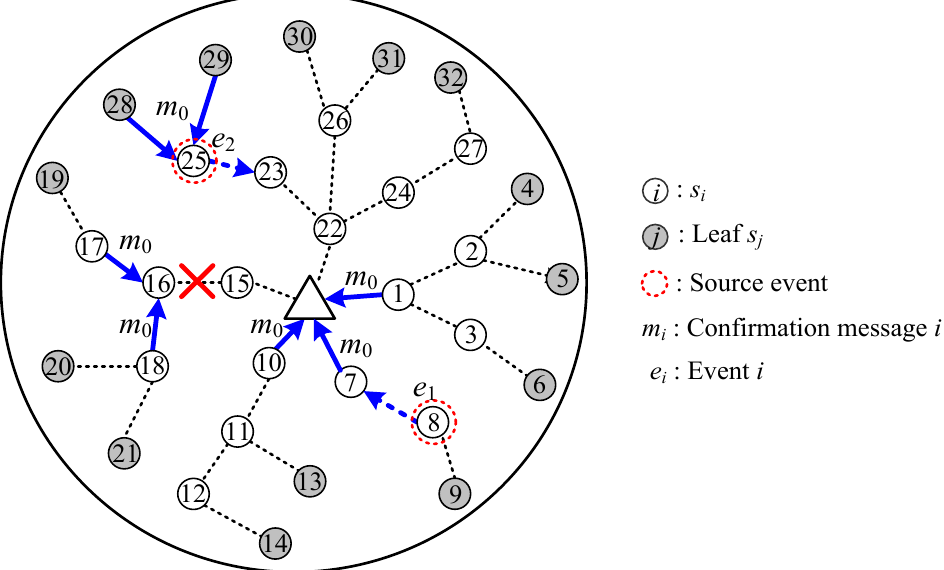
Figure 3. Fail link existed in events ordering